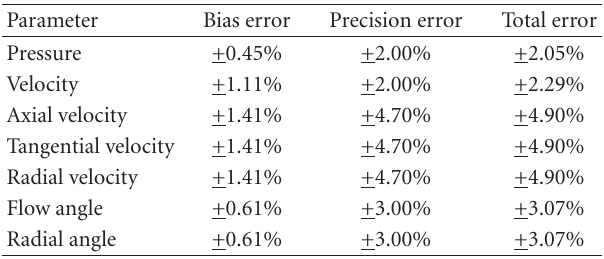
Table 3: Uncertainty in five hole probe